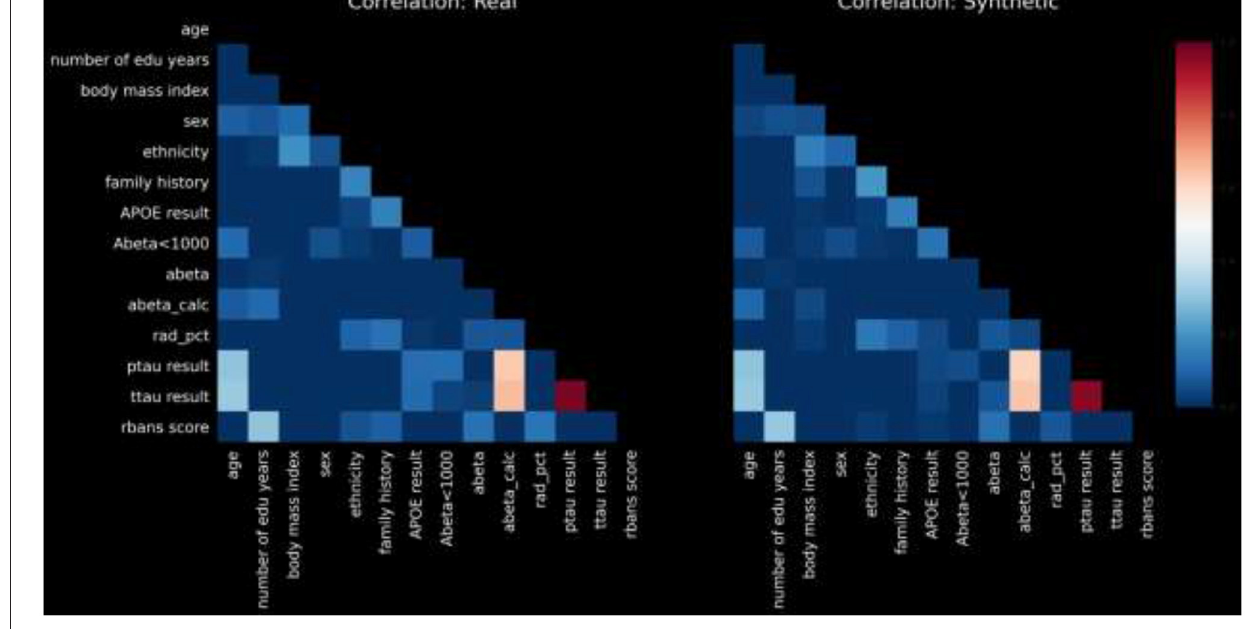
FIGURE 2 | Pairwise distributions.